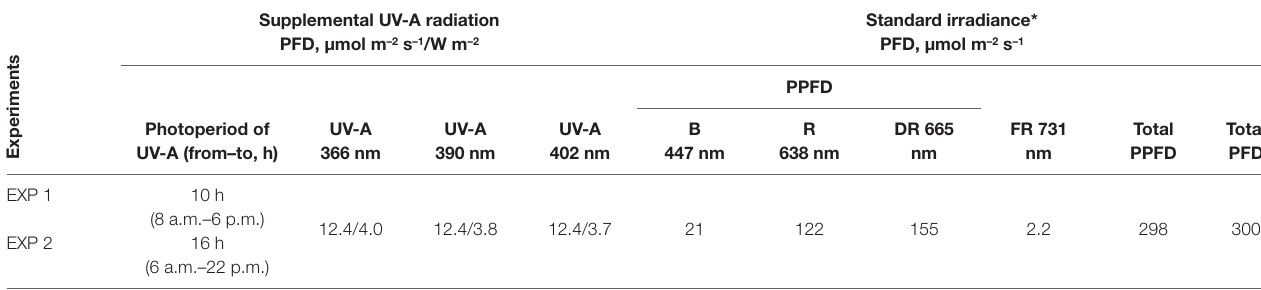
*Photoperiod of standard irradiance—16 h. EXP, experiment; UV-A, ultraviolet A; B, blue; R, red; DR, deep-red; FR, far-red; PPFD, photosynthetic photon flux density (400–700 nm); PFD, photon flux density of plant photomorphogenetic response wavelength range (300–800